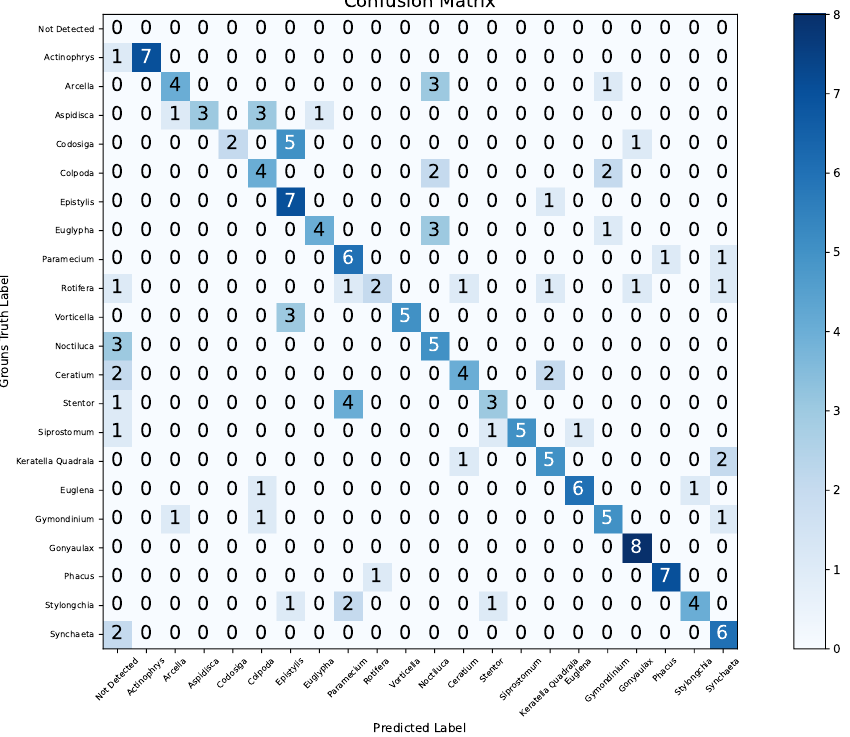
Figure 14. The confusion matrix of the detection results of SEM-RCNN on EMDS-6 (with 5-fold cross validation). Deeper color indicates the higher classification